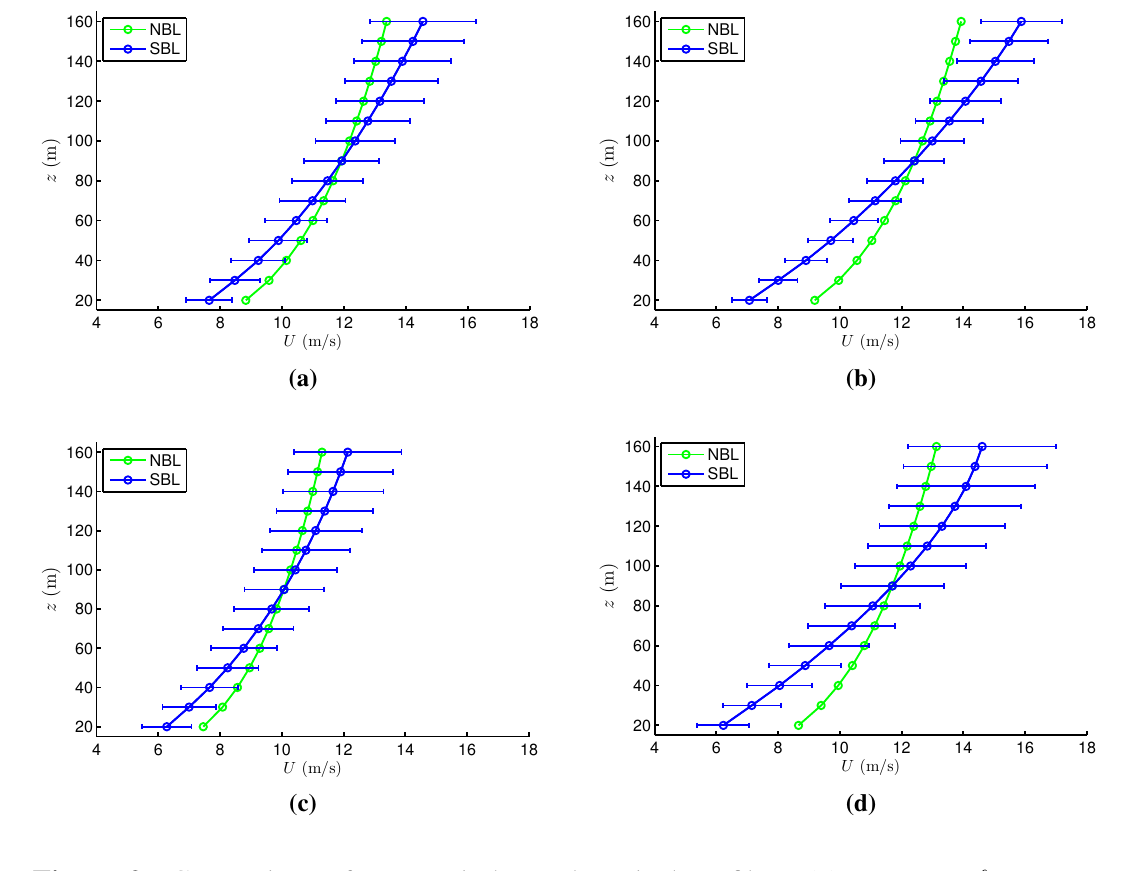
Figure 2. Comparison of mean wind speed vertical profiles. ( a ) z